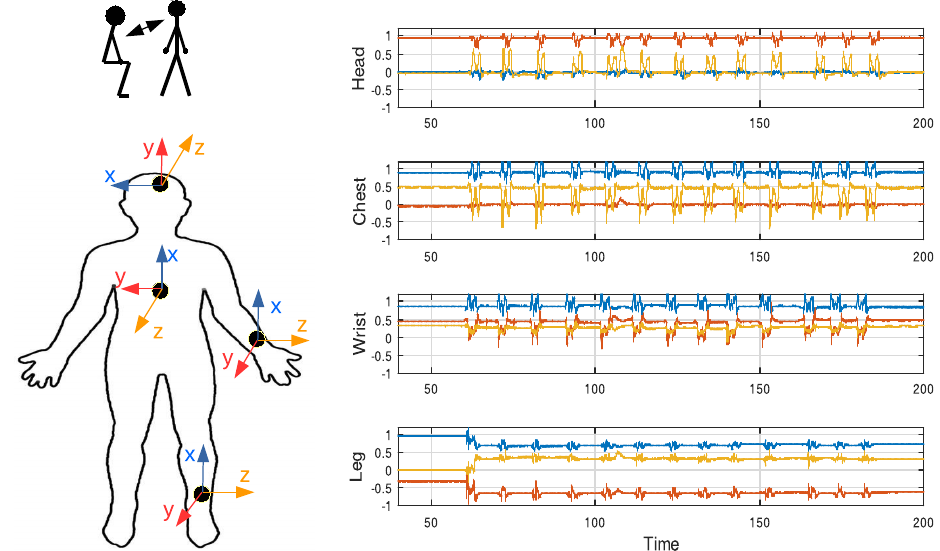
Figure 13. Accelerometer signals collected during the activity of sitting down and standing up. These movements cause oscillations in the IMUs data.